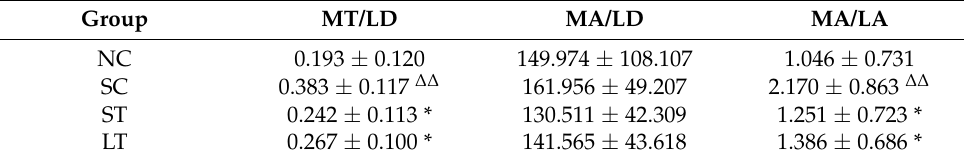
Figure 6. The branch of mesenteric artery. NC group ( A ), SC group ( B ), ST group ( C ), and LT group ( D ). Table 5. Morphological parameters of the branch of mesenteric artery after